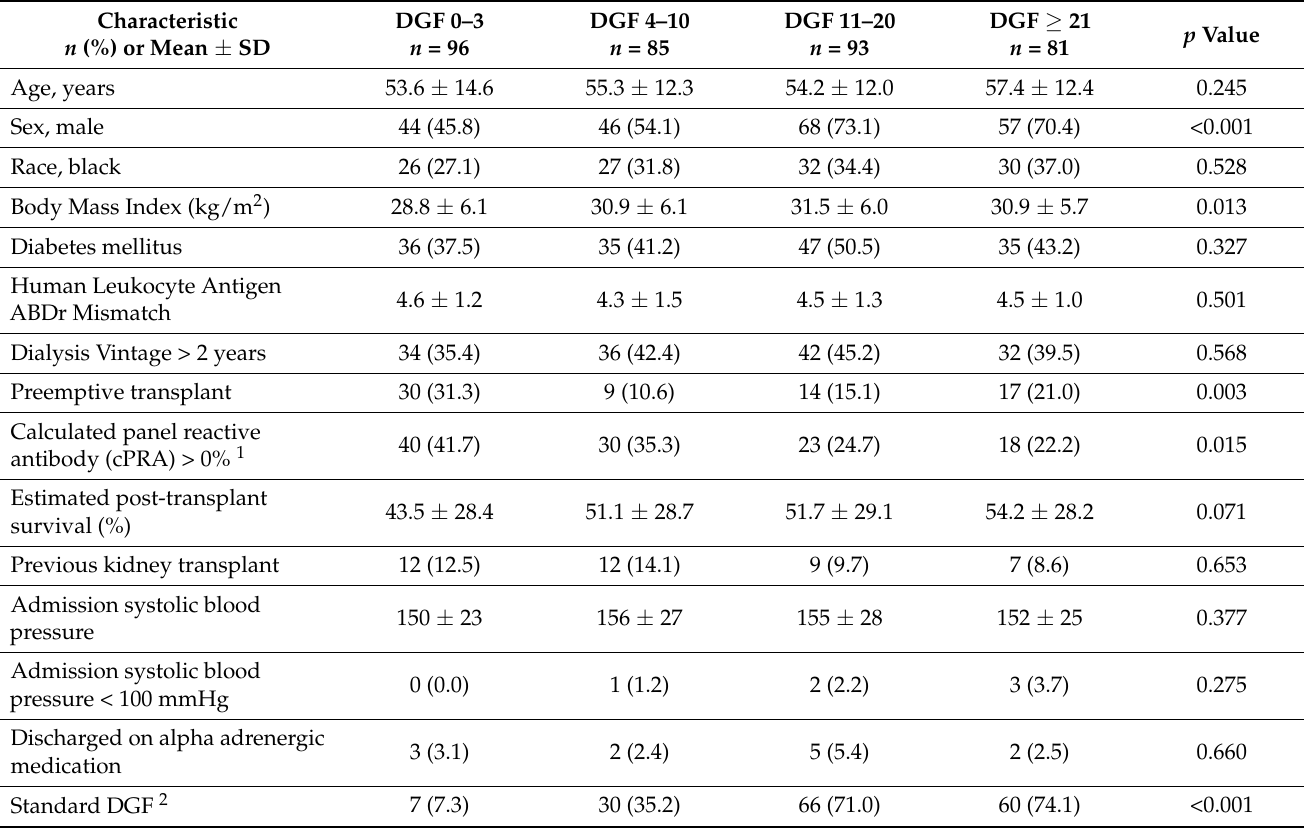
Table 2. Recipient characteristics across DGF duration